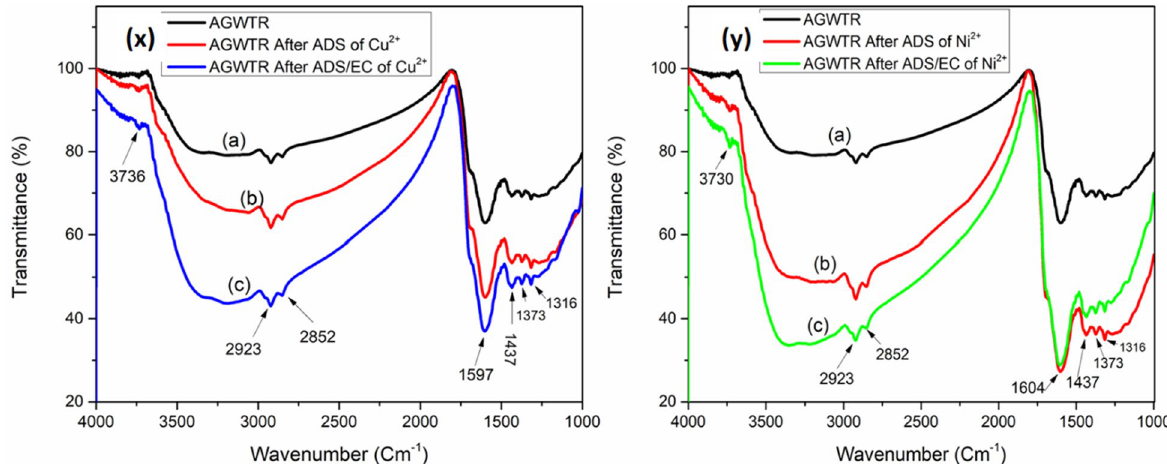
Figure 3. FT-IR spectroscopy characterization of activated green waste tea: ( X ) (a) AGWTR before adsorption, (b) AGWTR after adsorption of Cu 2+ and (c) AGWTR after ADS/EC of Cu 2+ . ( Y ) (a) AGWTR before adsorption, (b) AGWTR after adsorption of Ni 2+ and (c) AGWTR after ADS/EC of Ni 2+